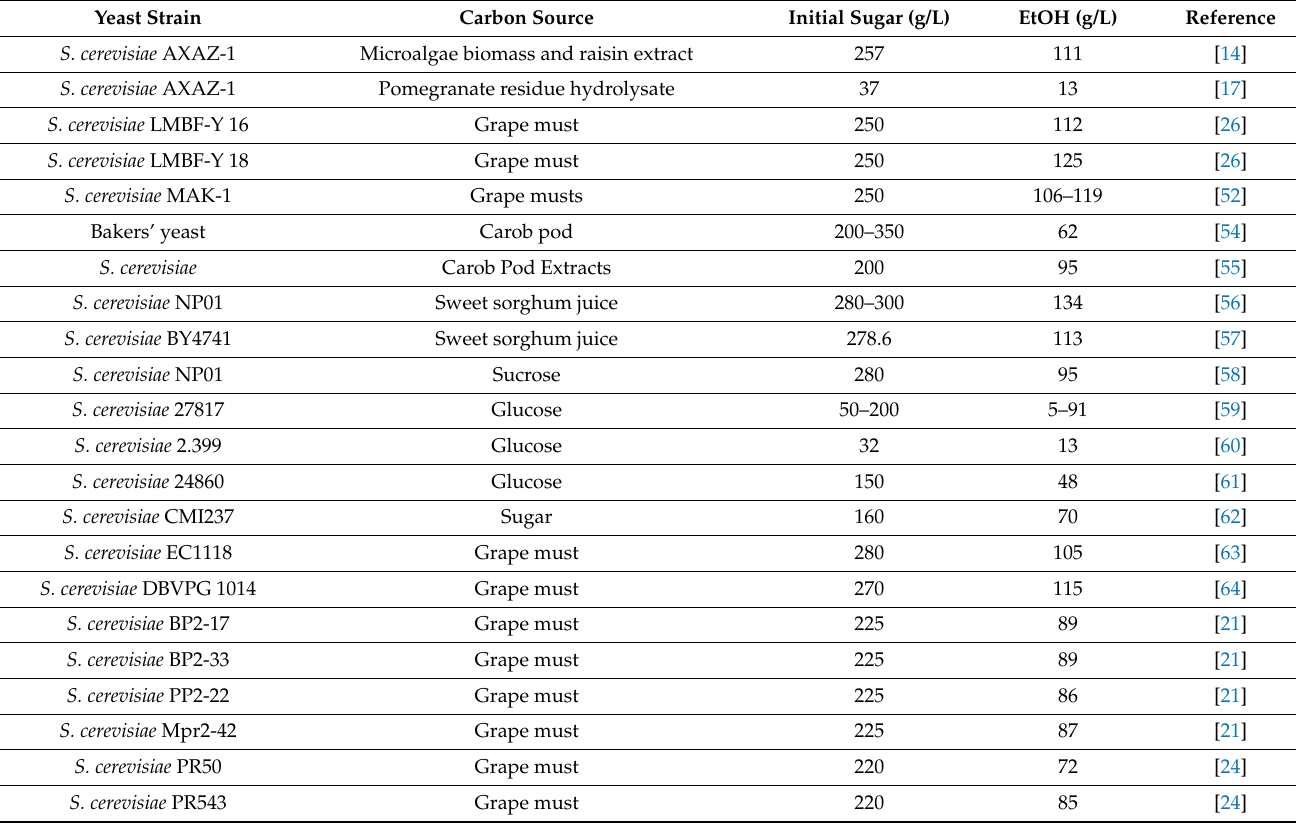
Table 3. Metrics for ethanol production of Saccharomyces cerevisiae different strains cultured on various carbon sources in comparison with results from the current